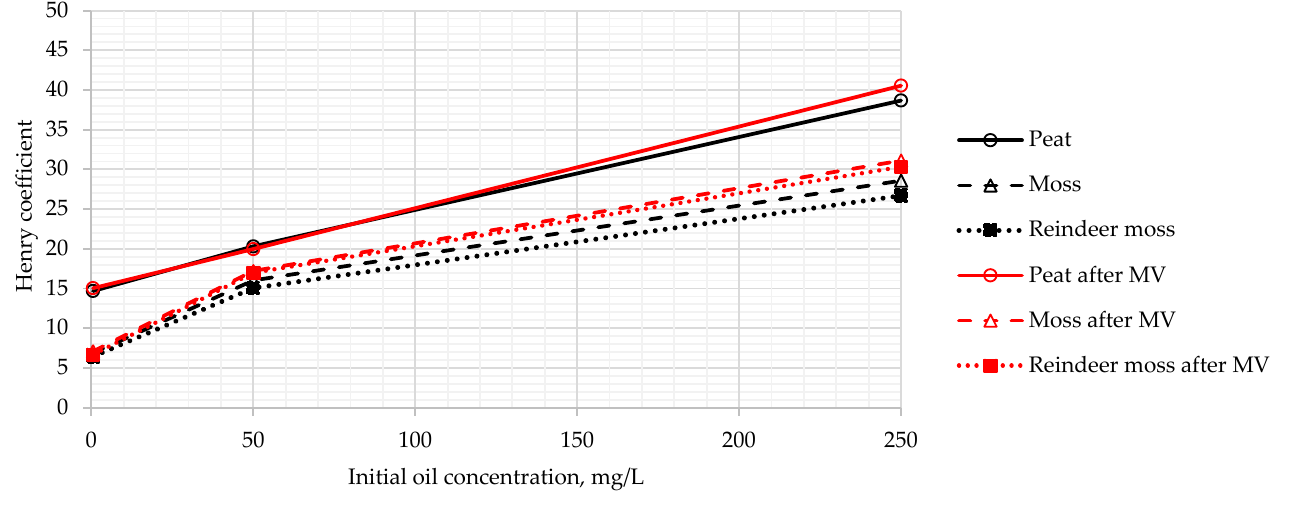
Figure 4. Change in the intensity of the oil adsorption process from a model aqueous solution based on the initial concentration.